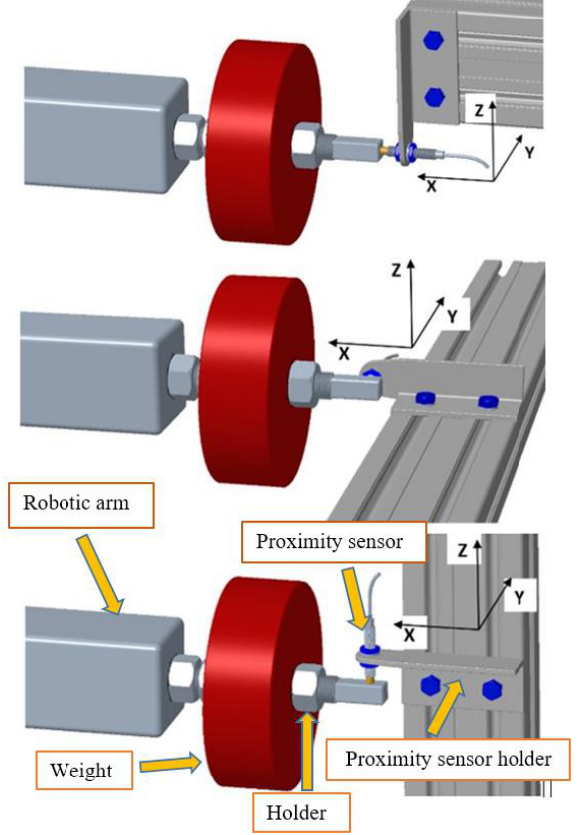
Figure 6. Non- contact measuring method (NcM) of robotic arm’s position deviation using a prox- Figure 6. Non-contact measuring method (NcM) of robotic arm’s position deviation using a proximity imity sensor in the direction of the X, Y, Z axis. sensor in the direction of the X, Y, Z axis.